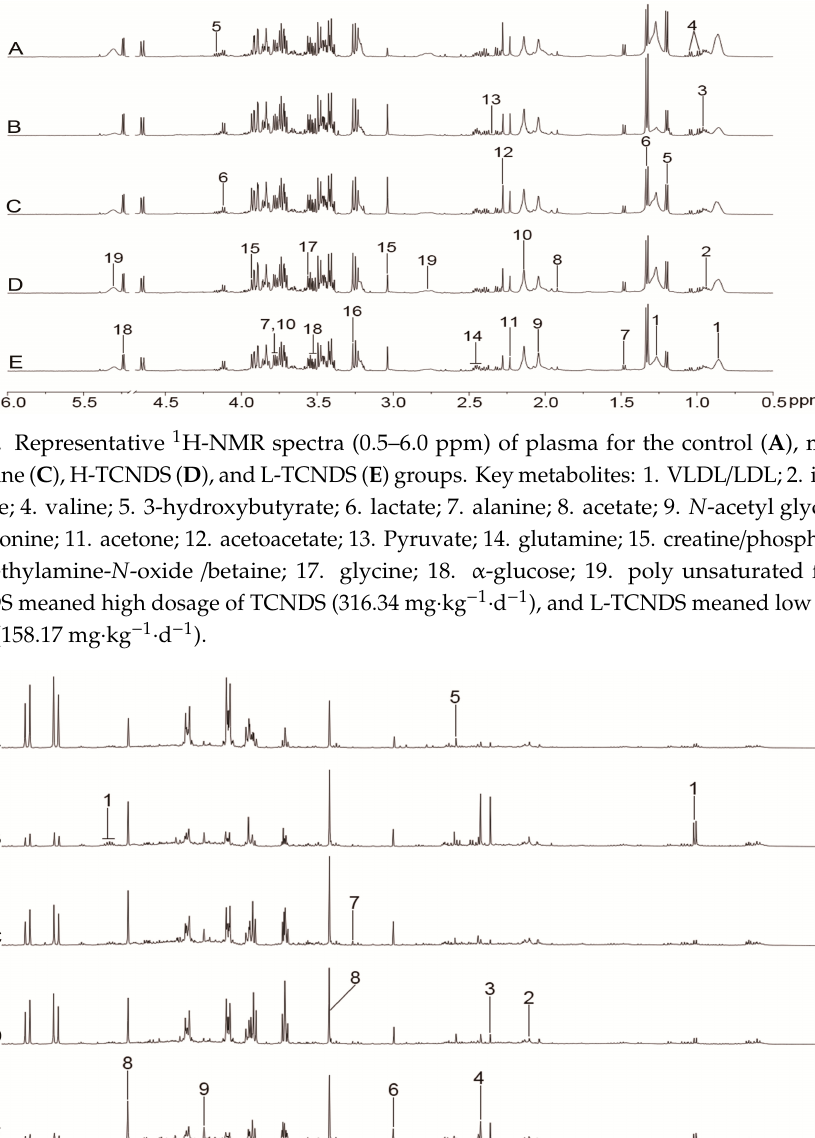
Figure 5. Representative 1 H-NMR spectra (0.5–4.7 ppm) of brain tissue for the control ( A ), model ( B ), nimodipine ( C ), H-TCNDS ( D ), and L-TCNDS ( E ) groups. Key metabolites: 1. isoleucine; 2. leucine; 3. valine; 4. lactate; 5. alanine; 6. acetate; 7. N -acetyl-aspartate; 8. N -acetylaspartylglutamate; 9. γ -aminobutyric acid; 10. glutamate; 11. succinate; 12. glutamine; 13. aspartate; 14. creatine/phosphocreatine; 15. choline; 16. phosphorylcholine/glycerophosphocholine; 17. scyllo-inositol; 18. taurine; 19. myo-inositol; 20. glycine. H-TCNDS meaned high dosage of TCNDS (316.34 mg·kg − 1 ·d − 1 ), and L-TCNDS meaned low dosage of TCNDS (158.17 mg·kg − 1 ·d − 1 ).